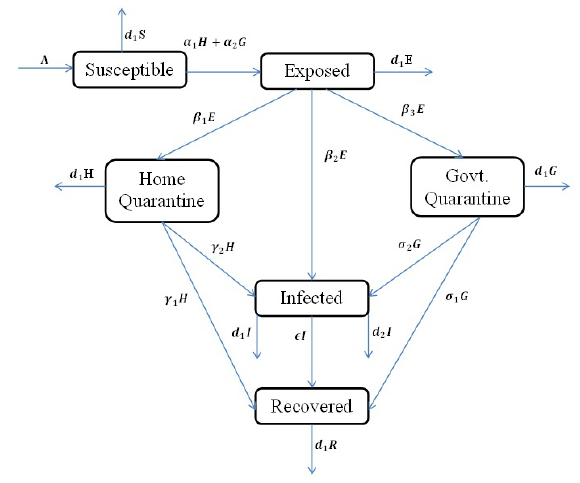
Fig. 1. Pictorial representation of proposed Covid 19 model for Indian